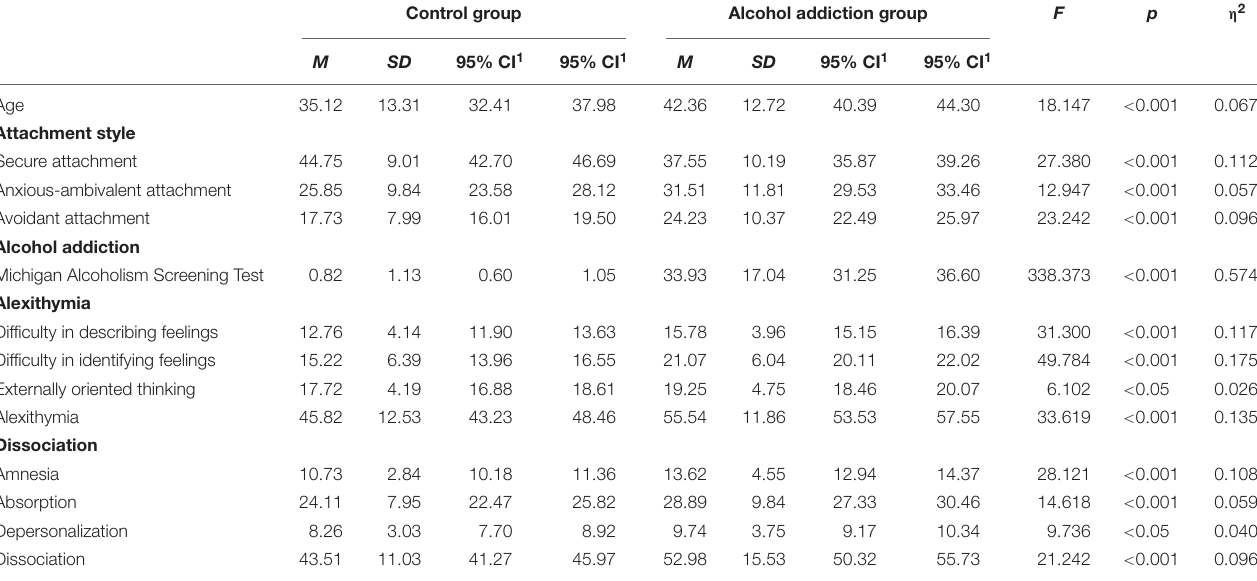
TABLE 1 | Demographic characteristics, attachment style, alexithymia, dissociation, and level of addiction in control group vs. alcohol addiction group. Control group Alcohol addiction group F p η 2